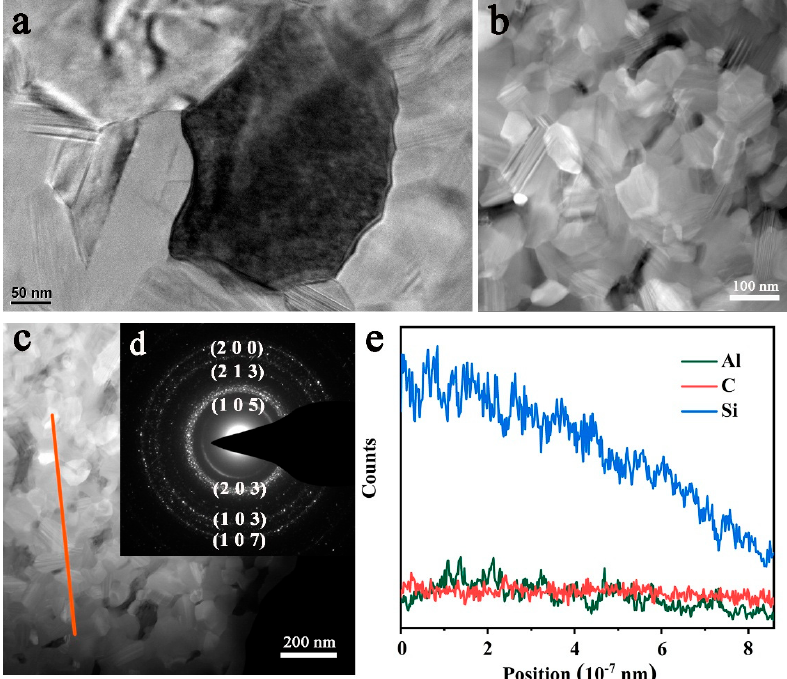
Figure 7. ( a )Transmission electron microscope (TEM); ( b ) and ( c ) high-angle annular dark field (HAADF); ( d ) selected area electron diffraction (SAED); ( e ) line scan of the orange line in Figure 7c in HAADF-STEM mode.